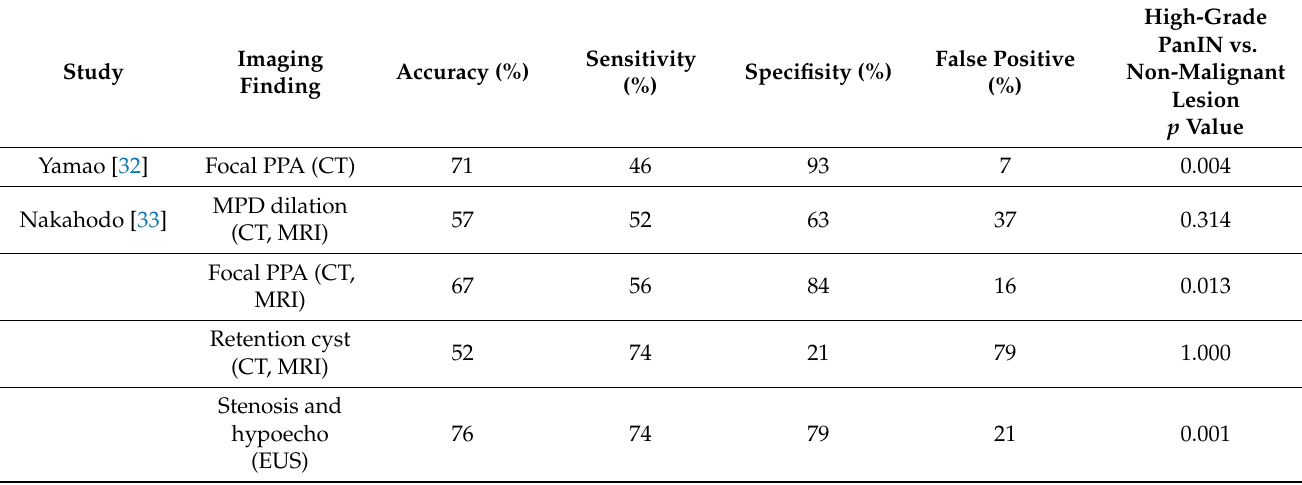
Table 2. Accuracy of indirect imaging finding of high-grade PanIN or small invasive cancer in comparison with non- malignant lesion.